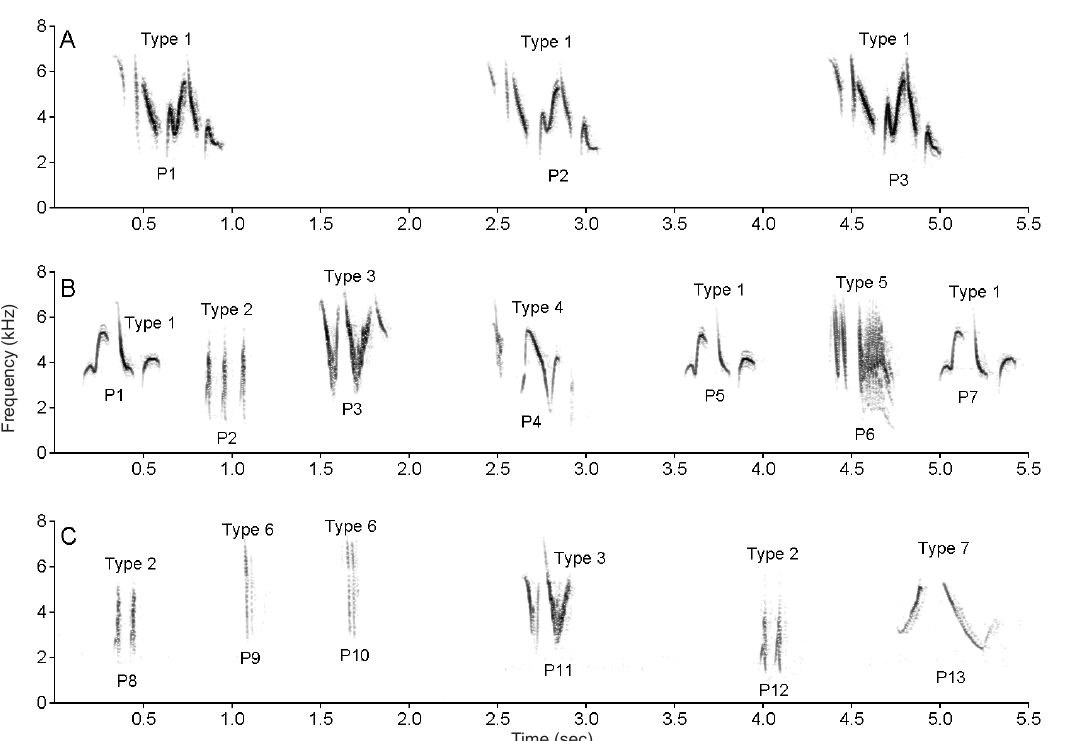
Figure 3. Song categories in the Indian Robin. A - Type-A song in stereotyped mode; B & C - Type-B song with 7 types of phrases with repetition of some phrases, such as